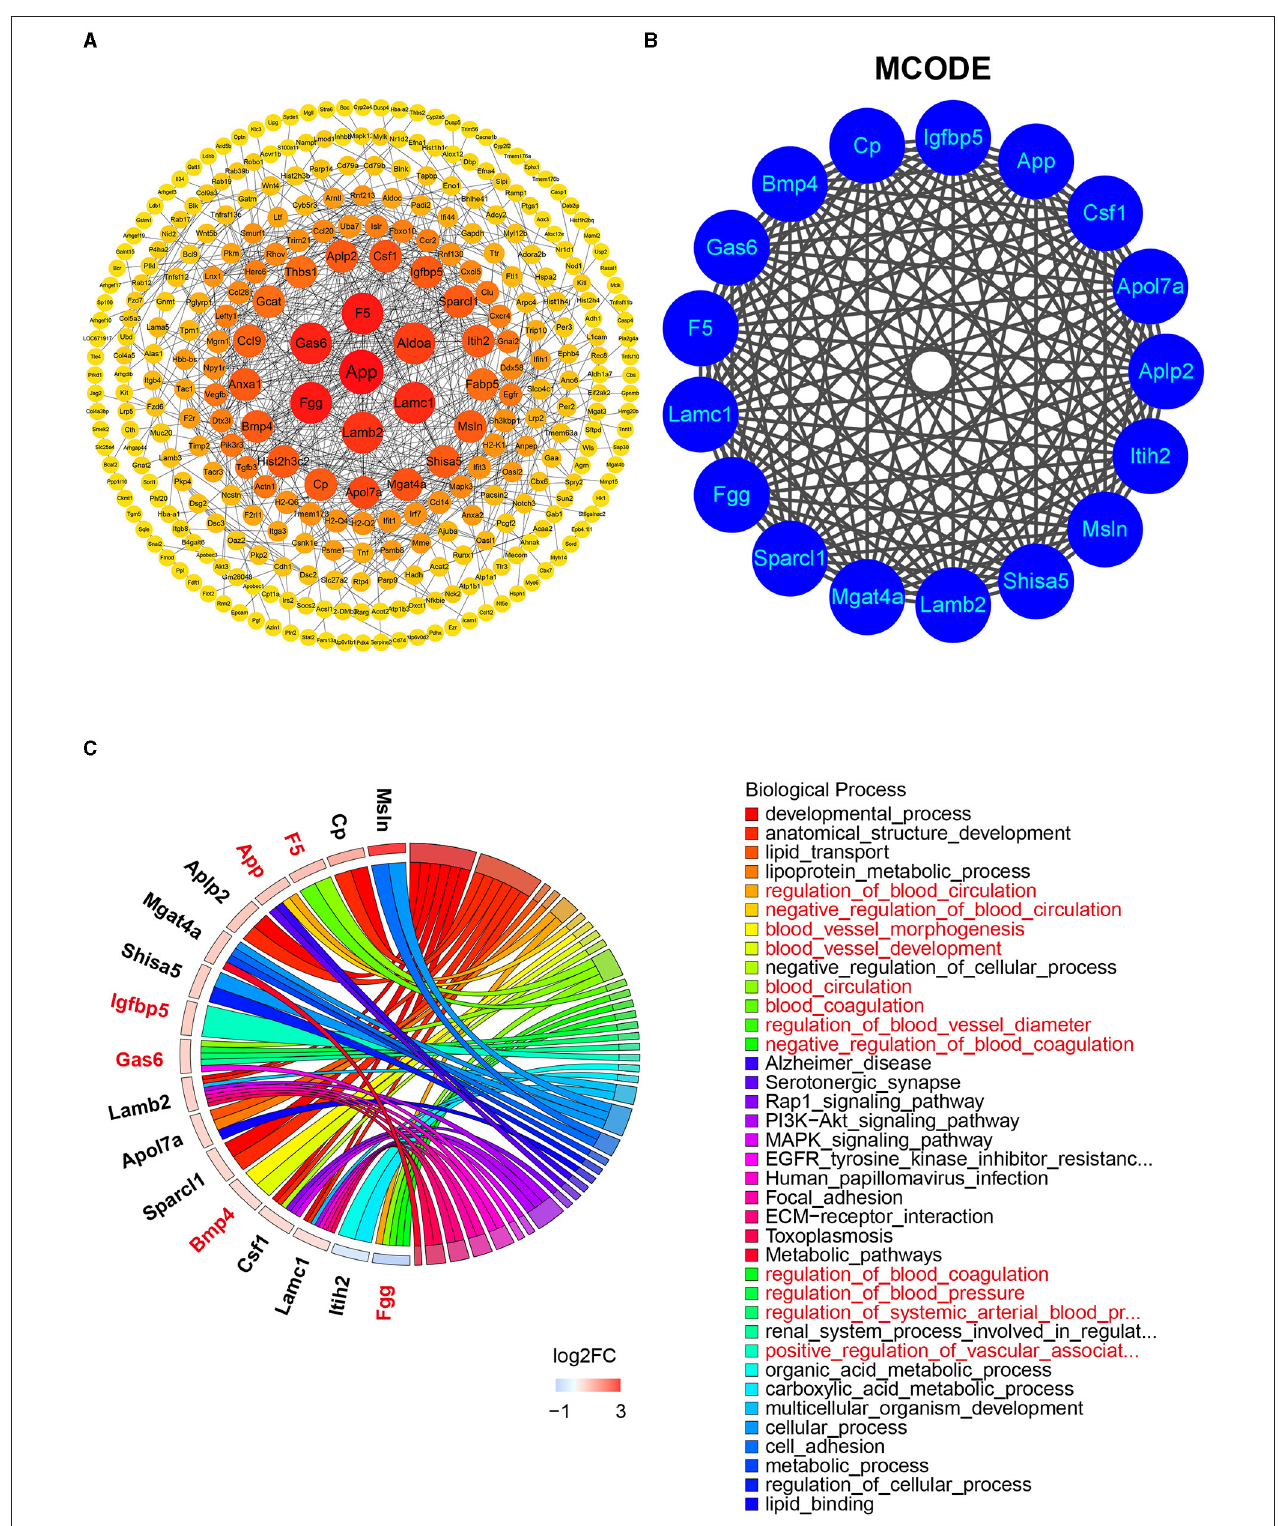
FIGURE 5 | The PPI network, MCODE analysis, and involved biological process. (A) The PPI network was analyzed by String and Cytoscape software. The sizes and colors of the nodes are illustrated from big to small and red to yellow in descending order of degree values. (B) The most significant module was identified by MCODE including 17 related genes (score = 17). (C) The biological process related to the 17 genes by GO analysis. Red color denoting genes and BPs associated with vascular process/regulations. DEG, differentially expressed gene; PPI, protein–protein interaction; MCODE, molecular complex detection; GO, gene ontology.